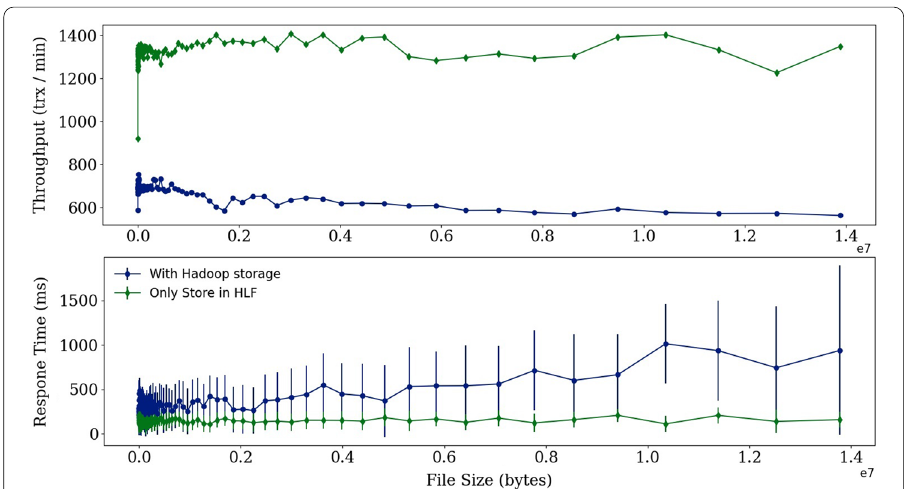
Fig. 5 Throughput and response time for various batch